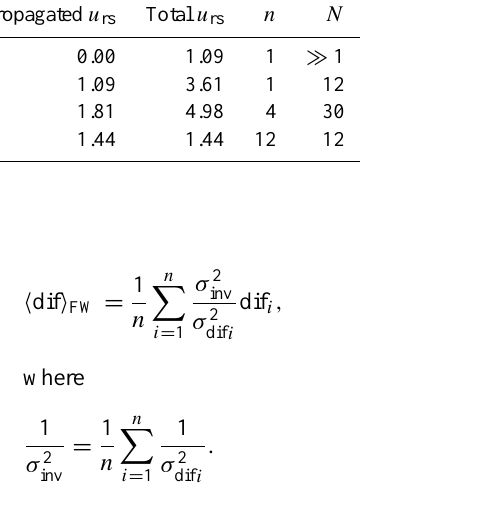
Table 4. Mean values of the representation uncertainty (nmolmol − 1 ) for different averaging periods from the NOAA flask air samples. Type of mean